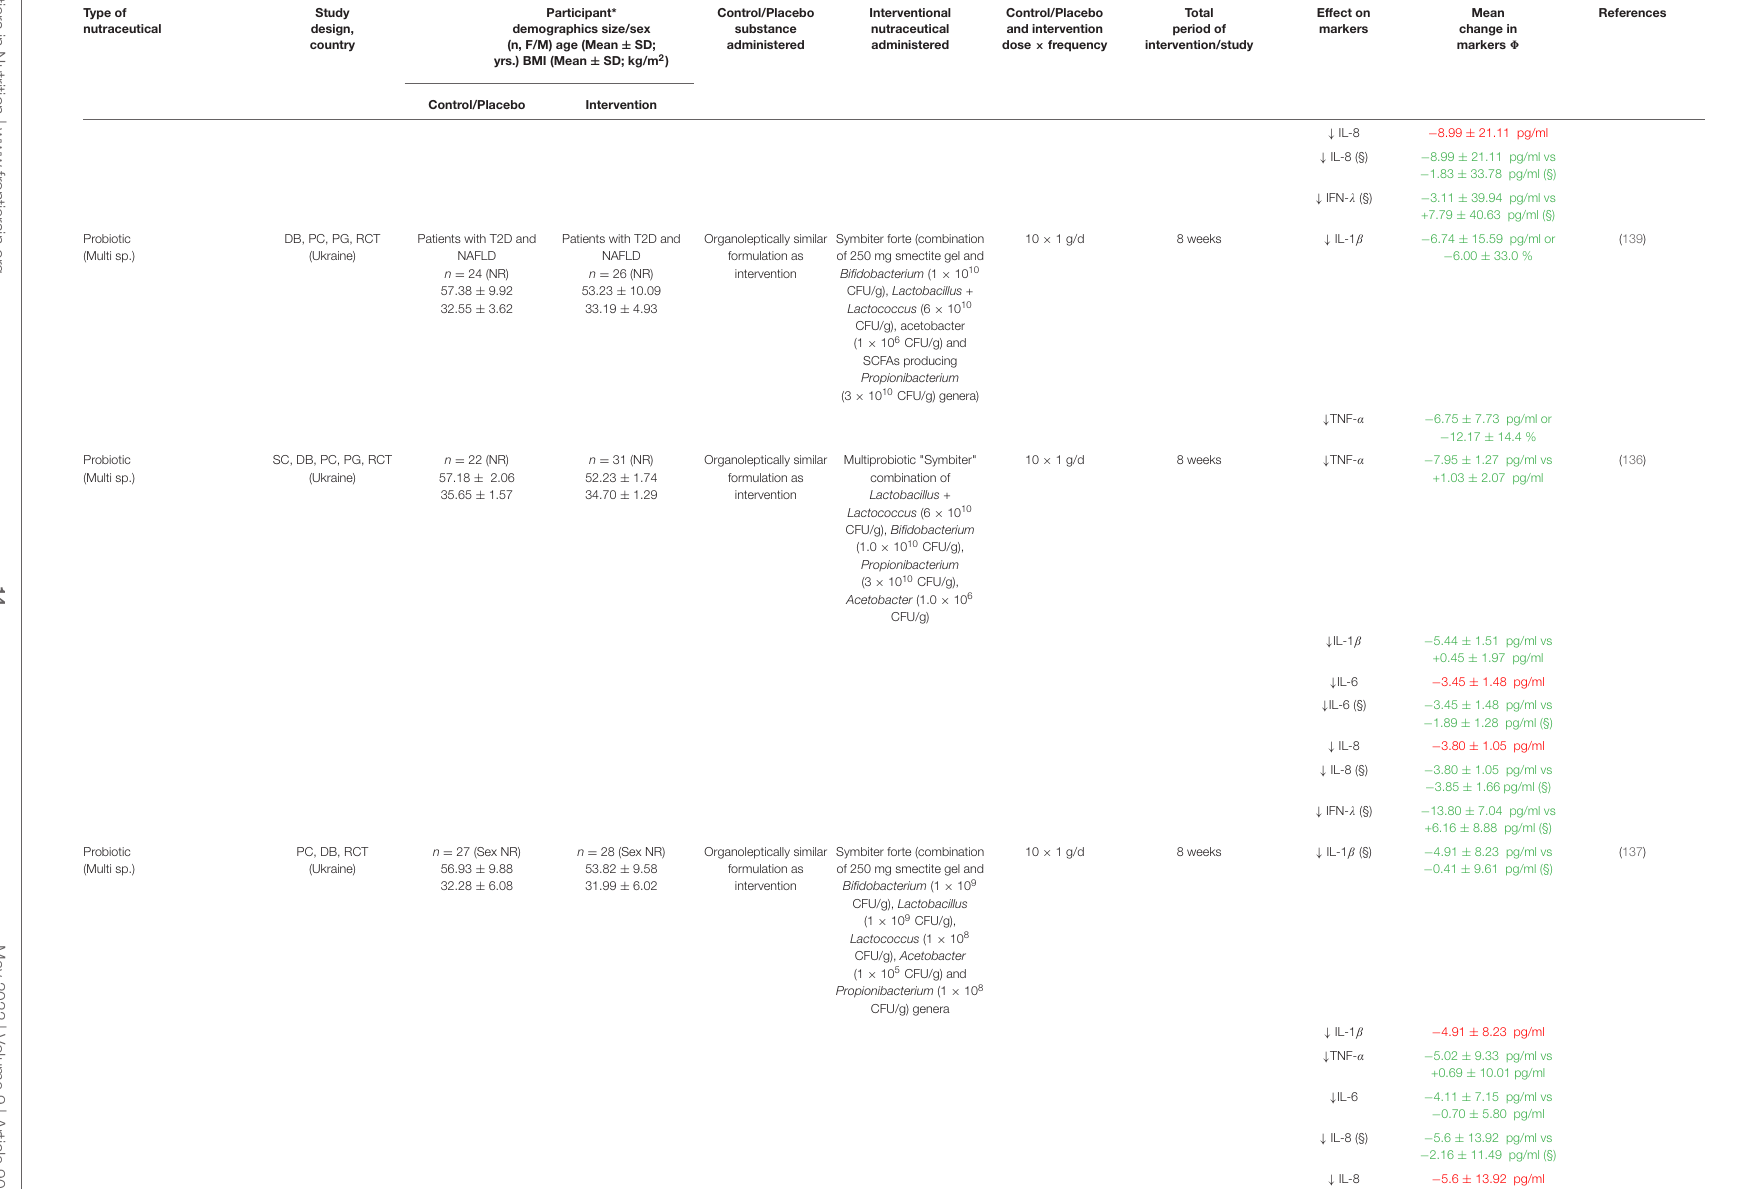
Symbiterforte(combination